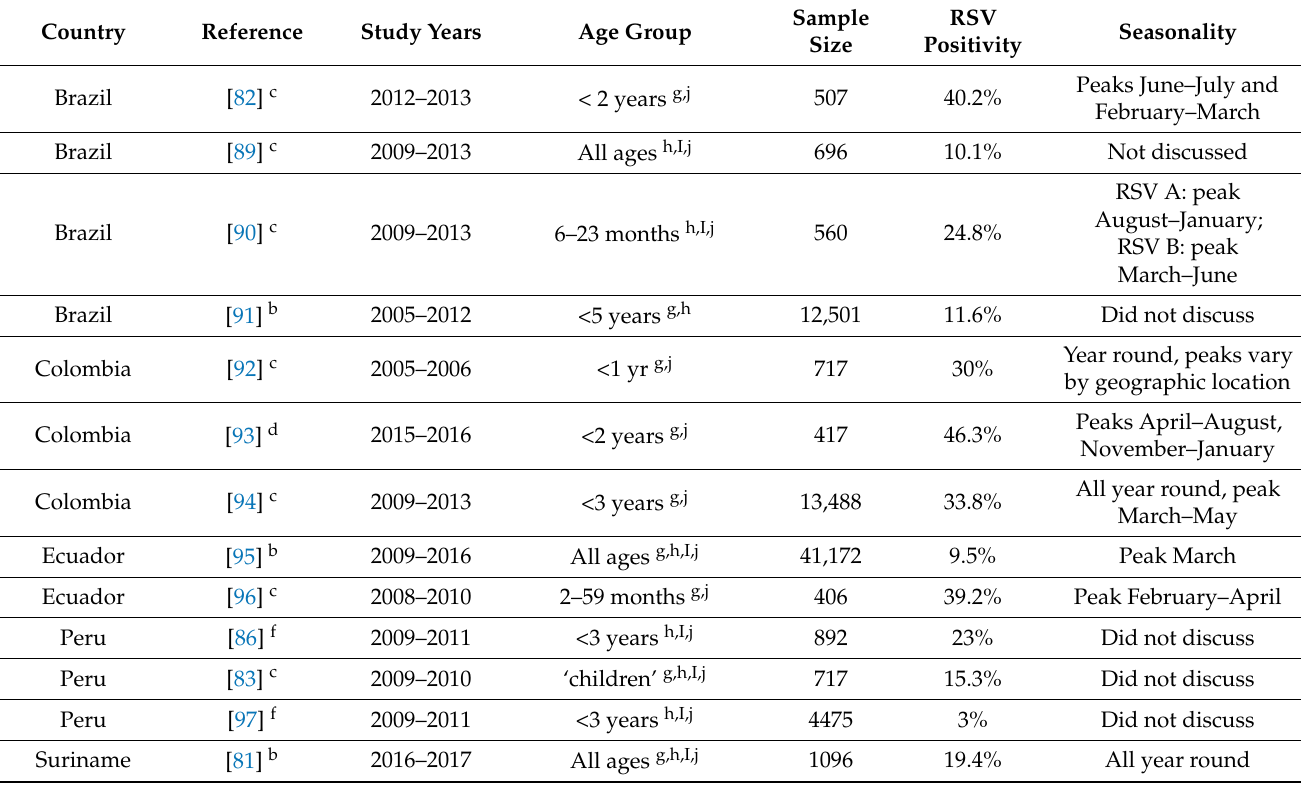
Table 3. RSV epidemiology in countries of tropical South